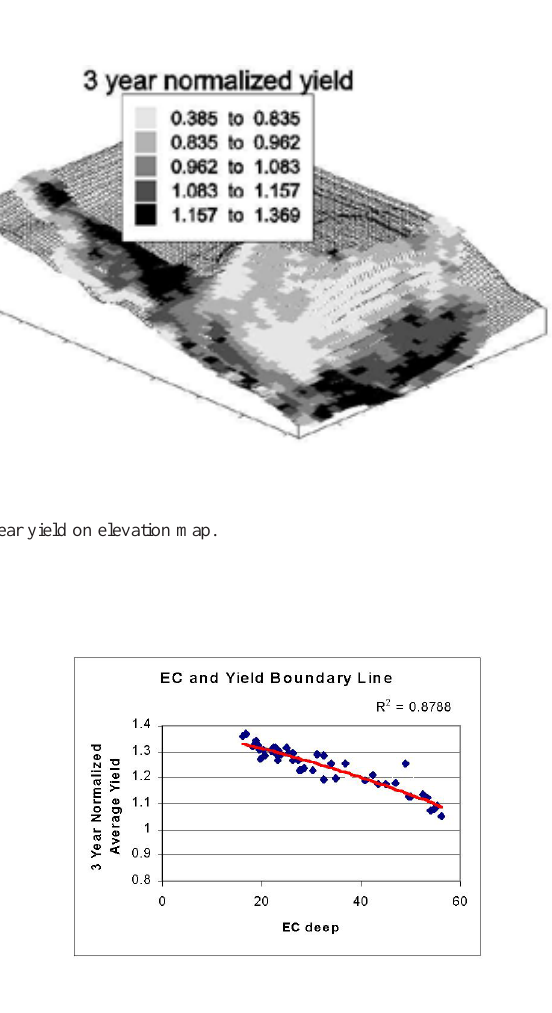
FIGURE 11. 1997, 1998, 1999 yields from an 18-ha Kansas field.